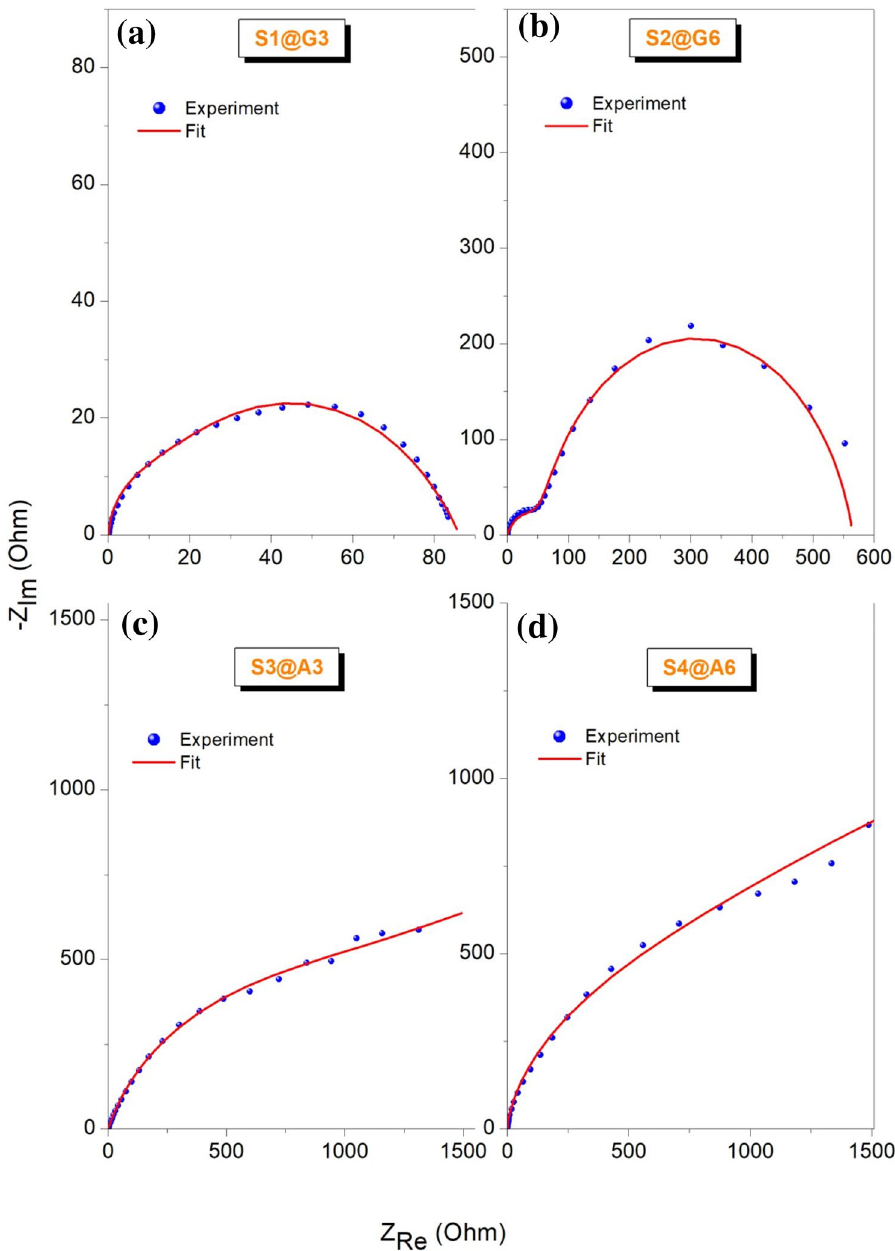
Figure 6. PEIS results of B 4 C materials obtained from the supercapacitor design given in Fig. 2. The red straight lines are the fitted curves obtained from ZFit software. The equivalent circuit and the values of each corresponding circuit elements have been listed in Supp. Material (Fig. S7 and Table S1) which helps fully to deduce the electrode